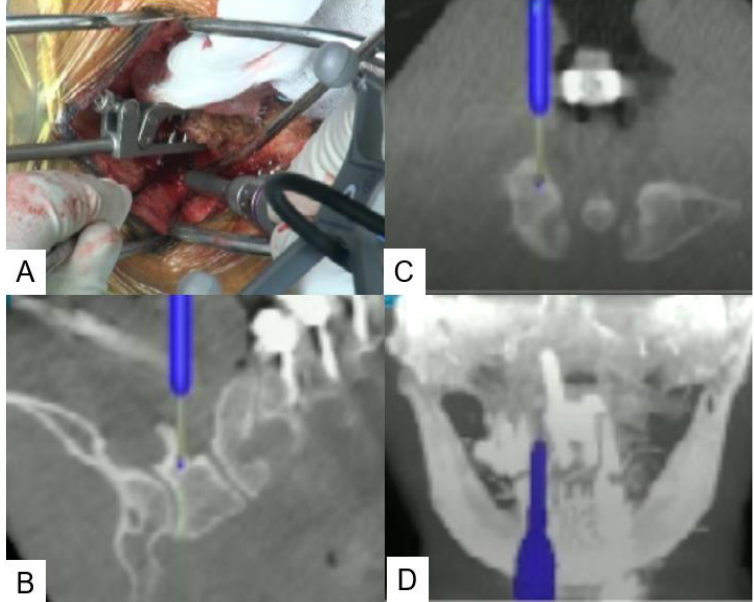
Figure 6. C1 lateral mass screw ( A ): intraoperative image, ( B ): sagittal view, ( C ): axial view, ( D ): coronal view.